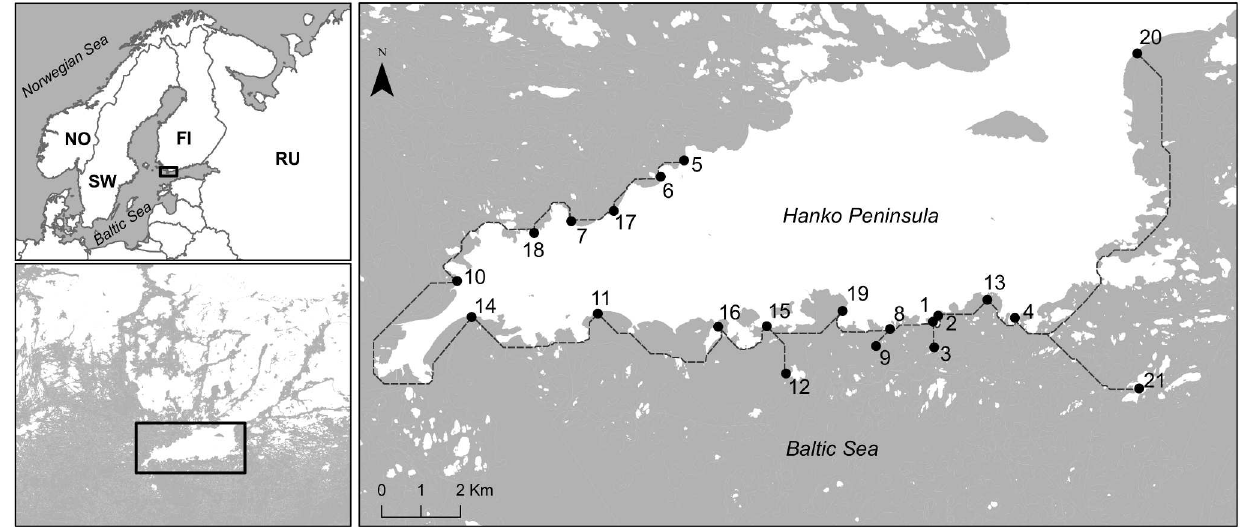
Fig 1. Map showing the location of the 21 beach sites around Hanko peninsula (Baltic Sea, Finland). The continuous dash-lineis an exampleof coastlinedistancesbetweensites simulatingthe hypothetical path of species dispersalacross the seawater(followinga GIS “cost- distance”raster, see Methods). “Countries, 2014—European Commission, Eurostat/GISCO.” Administrative boundaries: © EuroGeographics, © FAO (UN), © TurkStat Source: EuropeanCommission—Eurostat/GISCO. Containsdata from NationalLand Survey of FinlandTopographic map 1:100,000downloaded